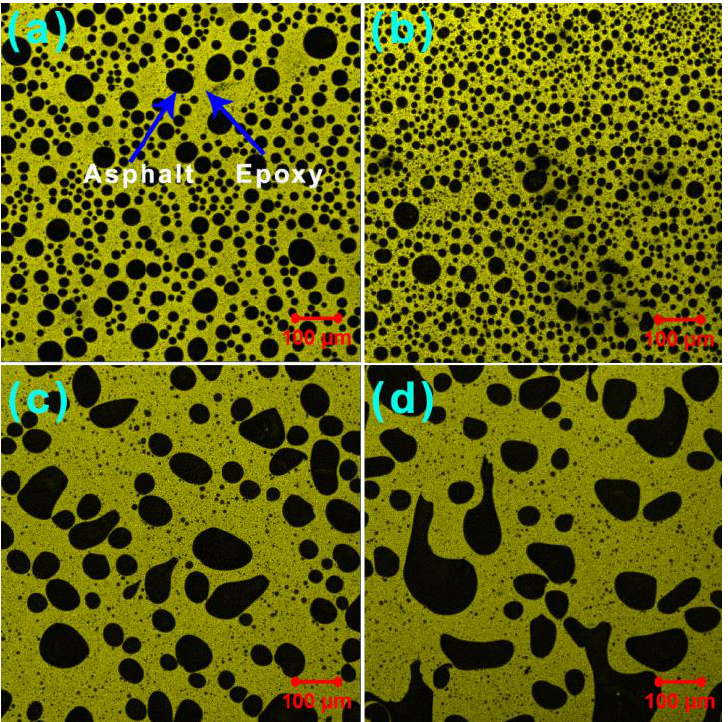
Figure 10. Fluorescence confocal microscopy photographs of the unmodified EABC ( a ) and GO- modified EABCs: 0.2 wt% ( b ), 0.5 wt% ( c ) and 1.0 wt% ( d ).